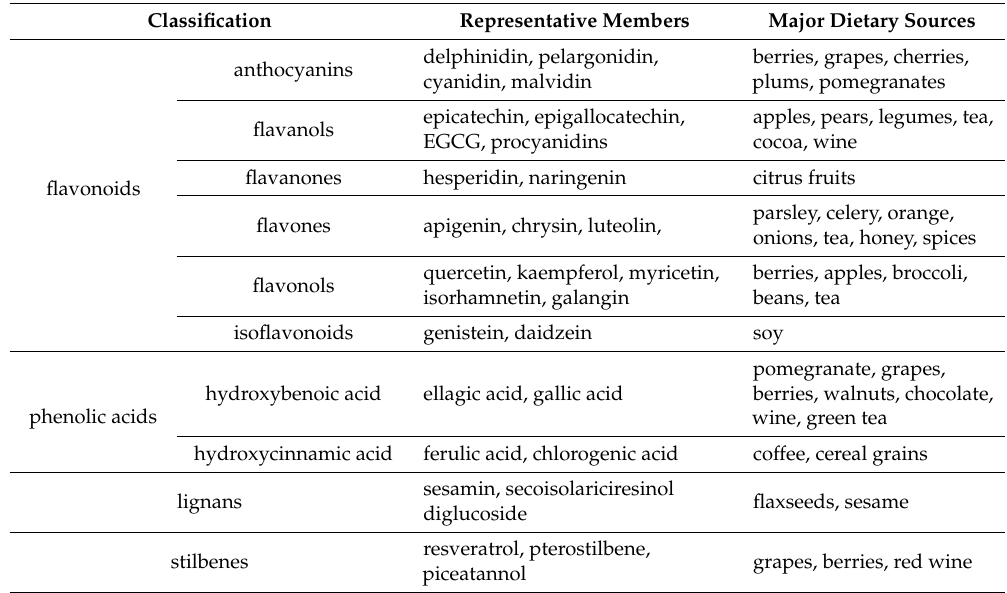
Table 1. The classification of natural